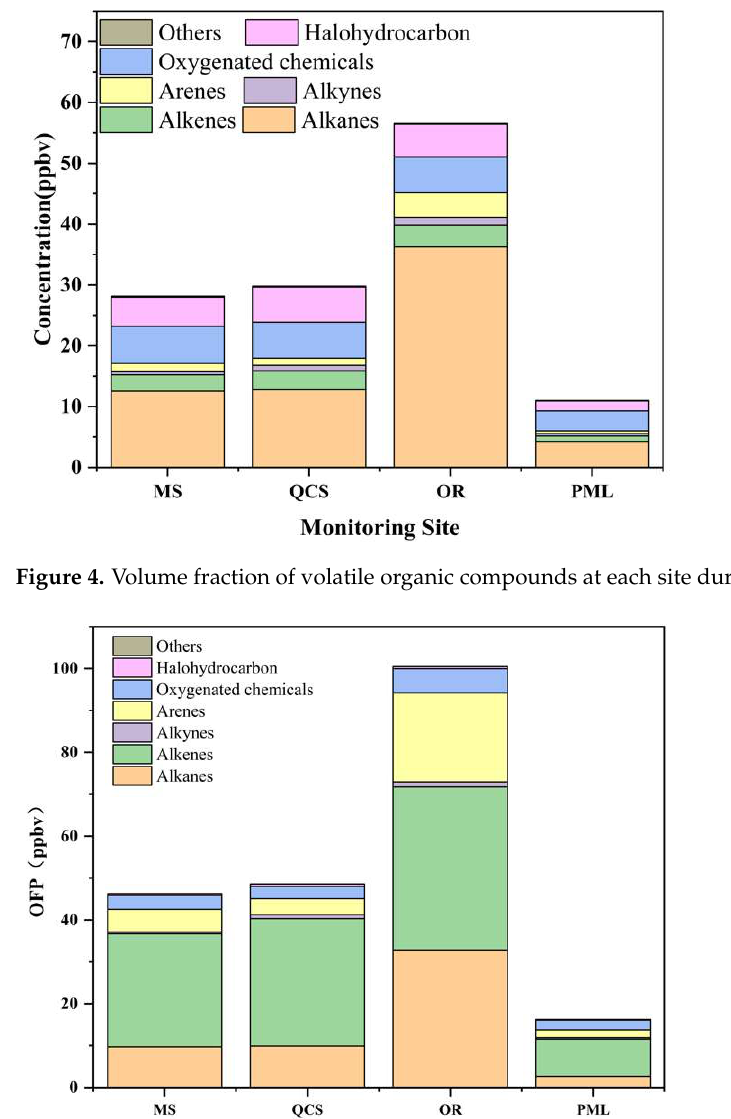
Figure 5. Ozone formation potential (OFP) values at each point during the